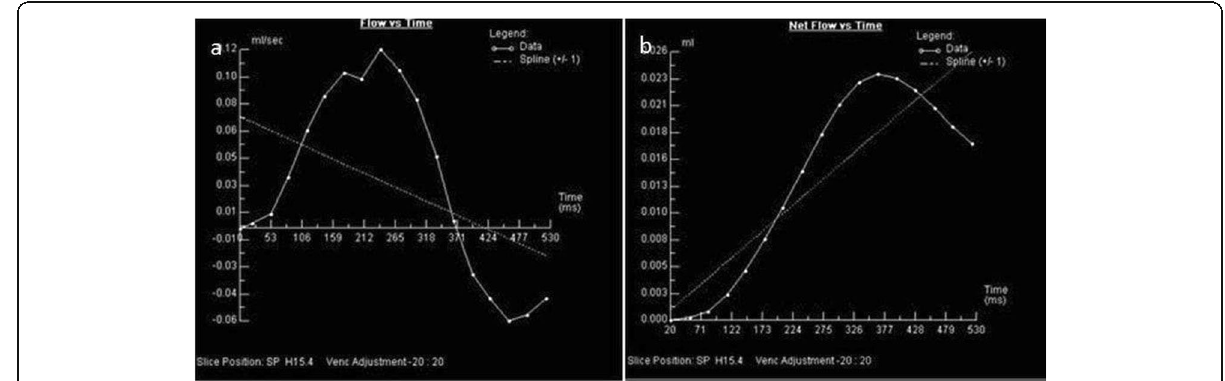
Fig. 2 Graphs for ( a ) flow versus time and ( b ) net flow versus